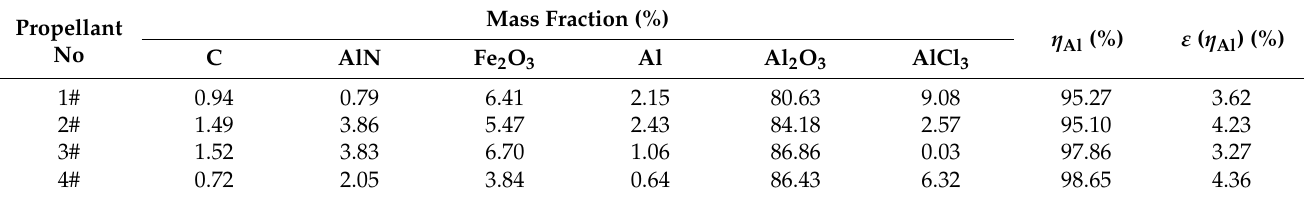
Table 4. Chemical Analysis of CCPs.